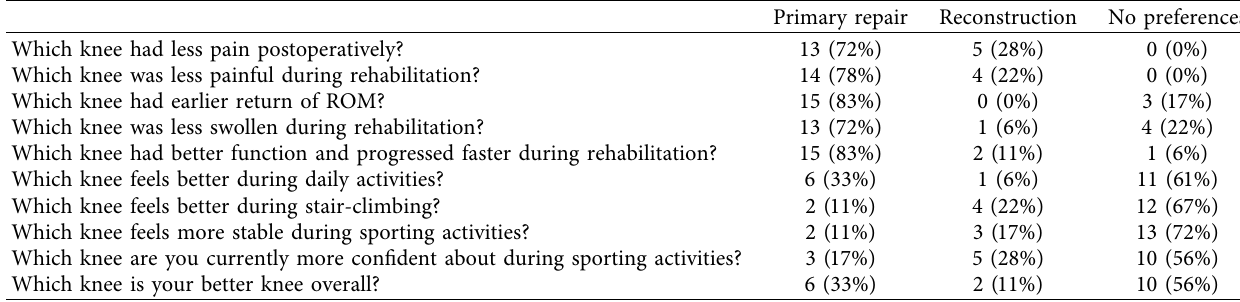
Table 2: Preferences between both knees following primary ACL repair and ALC reconstruction in the same patient ∗ .